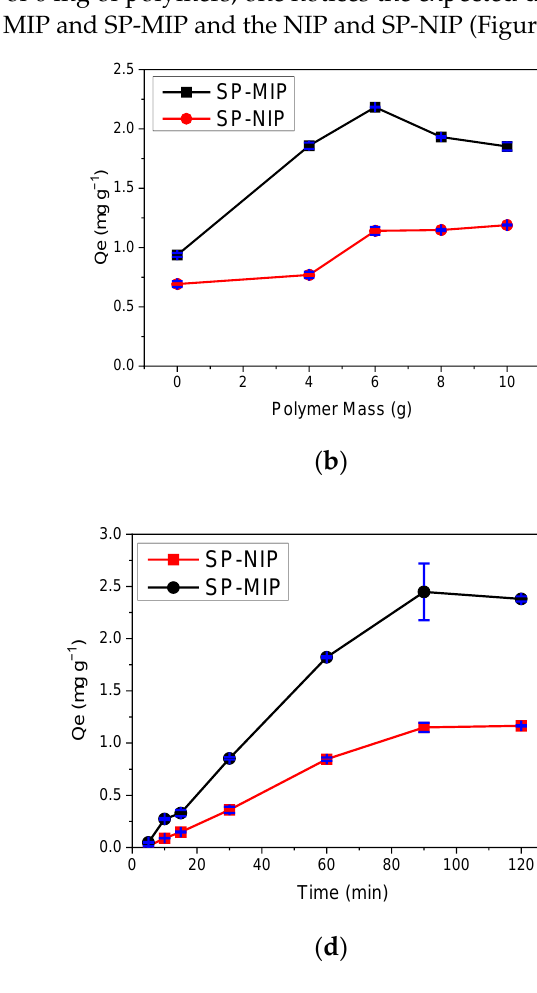
Figure 9. Results obtained from the optimization of adsorption on SP-MIP and SP-NIP with ( a ) pH effect, ( b ) polymer mass effect, ( c ) AMX concentration effect, and ( d ) time. All measurements were carried out in triplicate. Table 3 outlines the optimal conditions obtained for the AMX adsorption Table 3. Optimal conditions for the Amoxicillin (AMX) adsorption process. Parameter